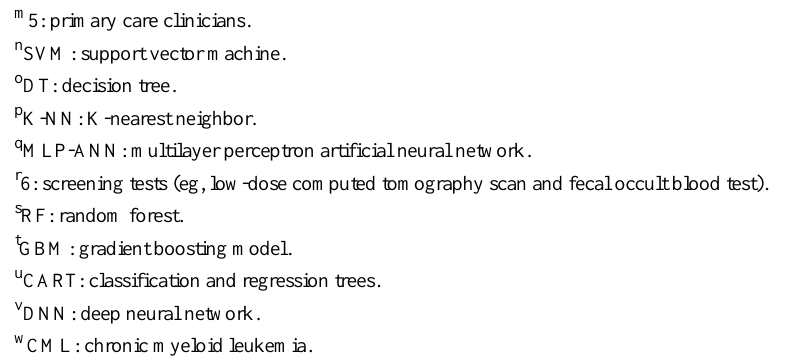
r 6: screening tests (eg, low-dose computed tomography scan and fecal occult blood test). s RF: random forest. t GBM: gradient boosting model. u CART: classification and regression trees. v DNN: deep neural network. w CML: chronic myeloid